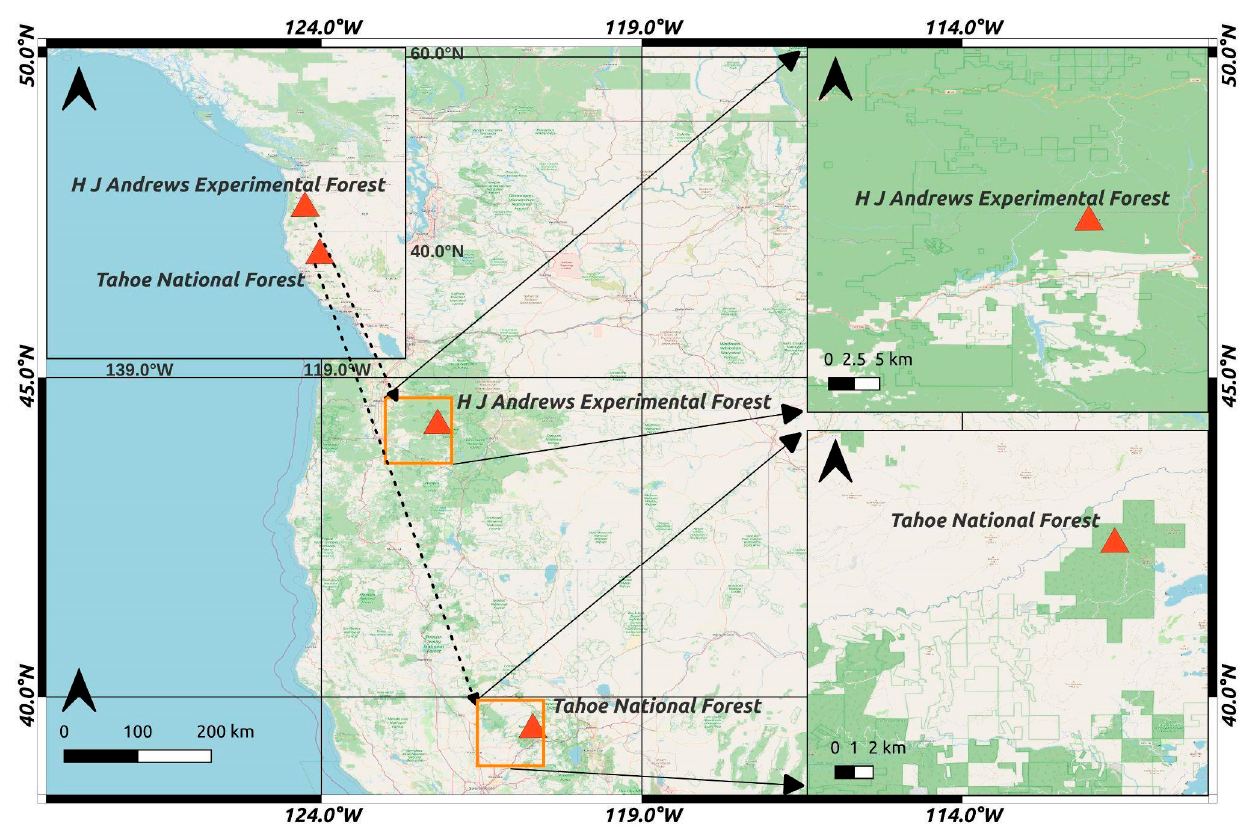
Figure 2. Map of the study area for the proposed study.